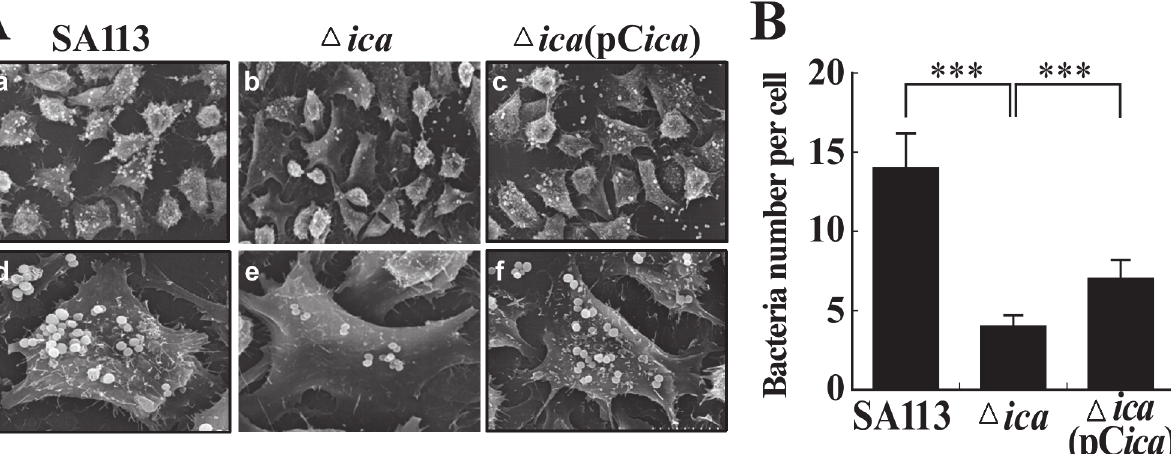
Fig 2. SEM images of adhesion of S . aureus to RPMI 2650 cells. (A) RPMI 2650 cells were incubated with S . aureus SA113 (a, d), SA113 Δ ica (b, e) and SA113 Δ ica (pC ica ) (c, f). The images were captured at a magnification of 1000x (a, b, c) and 3000x (d, e, f). The number of bacteria that adhered to 400 cells was enumerated, and the average number of bacteria on each cell was calculated (B). Significant differences are denoted with *** p -value <